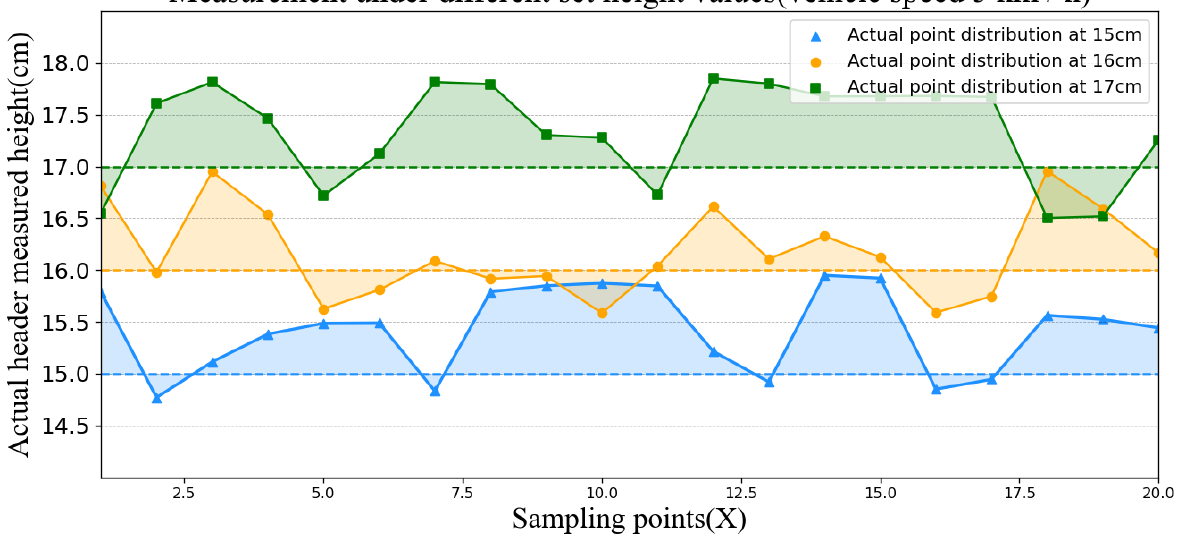
Figure 23. Comparison of different heights at a speed of 5 km/h.